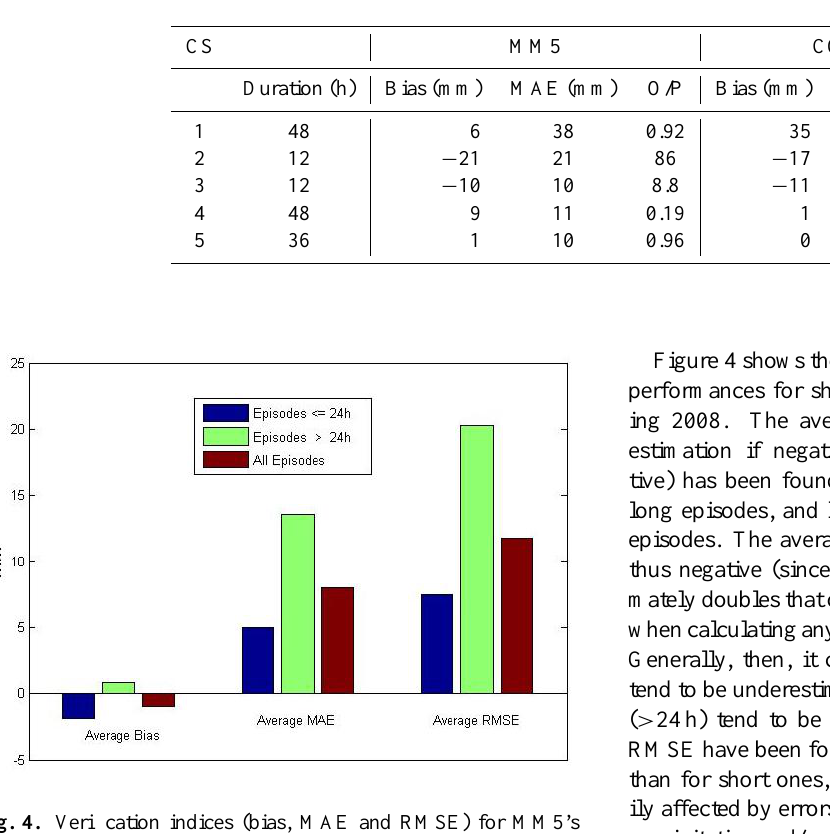
Fig. 4. Verification indices (bias, MAE and RMSE) for MM5’s QPFs against rainfall observations for all warning episodes during Figure 4. Verification indices (bias, MAE and RMSE) for MM5‟s QPF against rainfall 3 observations for all warning episodes during 2008. 4